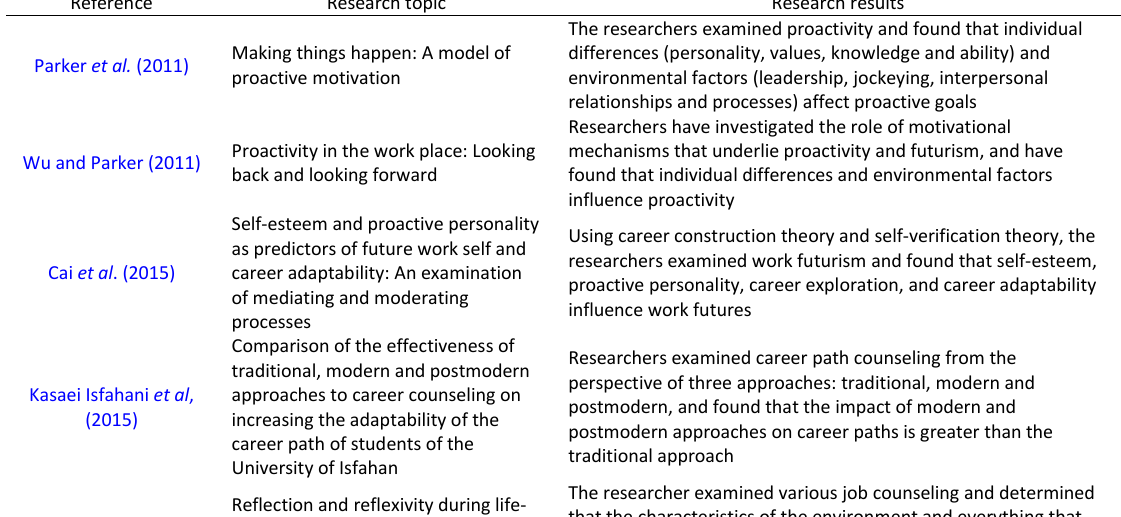
Table 1: Studies and research conducted in relation to the subject of research